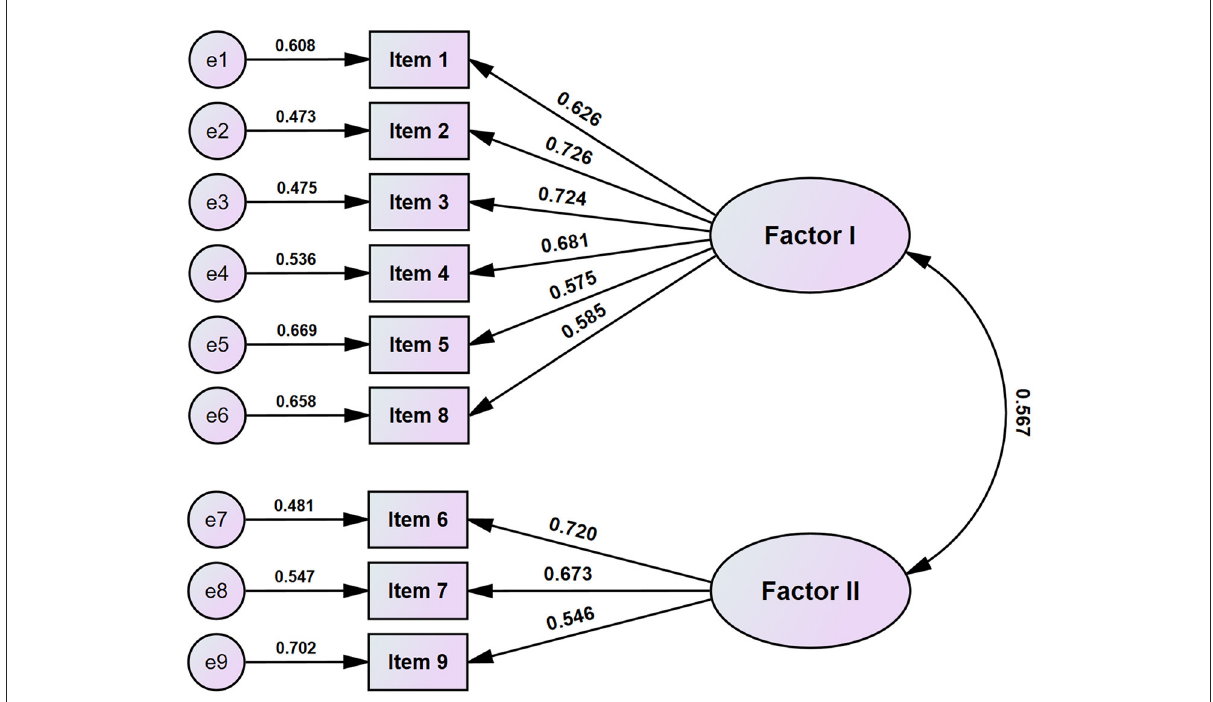
FIGURE1 Factor structure of the SAVE-9 scale among nursing professionals working in COVID-19 inpatients ward.